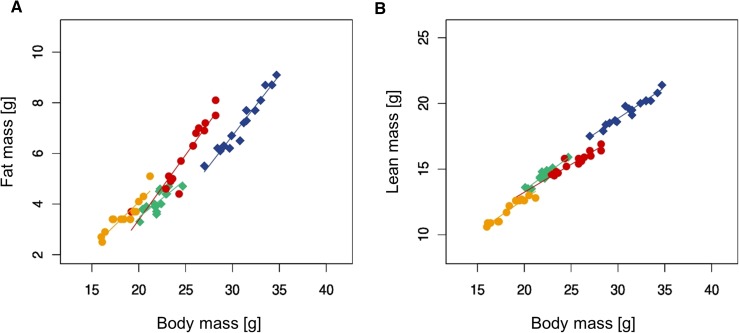
(A) Fat mass plotted against body mass (green, Scube3N294K/N294K males; yellow, Scube3N294K/N294K females; blue, Scube3WT males; and red, Scube3WT females). (B) Lean mass plotted against body mass (green, Scube3N294K/N294K males; yellow, Scube3N294K/N294K females; blue, Scube3WT males; and red, Scube3WT females).